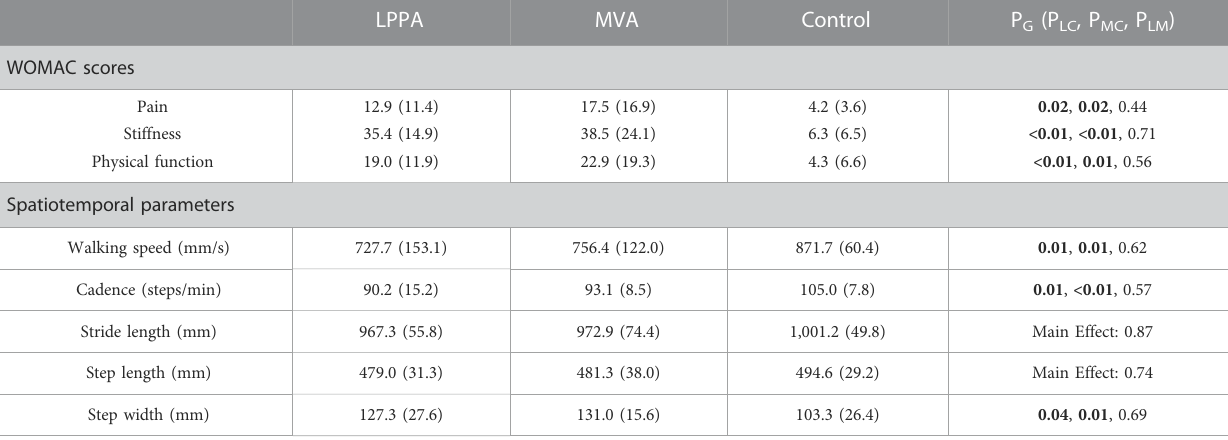
TABLE 1 Means (standard deviations) of the WOMAC scores and spatiotemporal parameters during walking in the LPPA, MVA, and Control groups. p -values for comparisons between patient and Control groups using independent t -tests are also given.